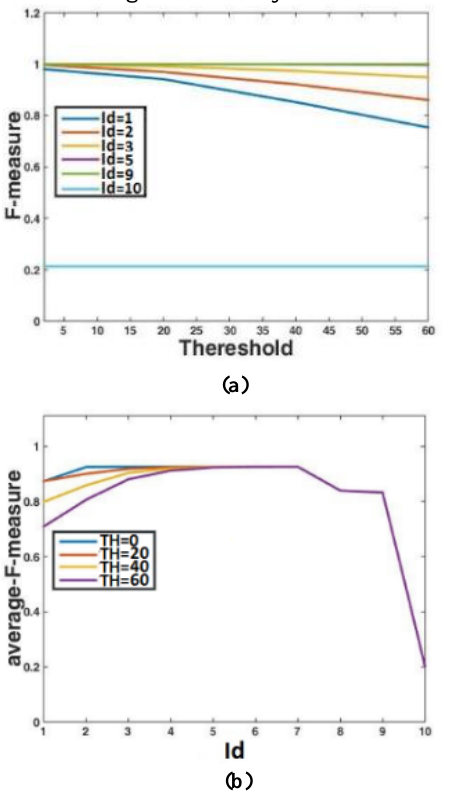
Figure 14. Effects of the algorithm parameters on the F- measure. a) As the threshold increases the F-measure decreases. b) For IDS between 4 and 8 the maximum F- measure value has been achieved.